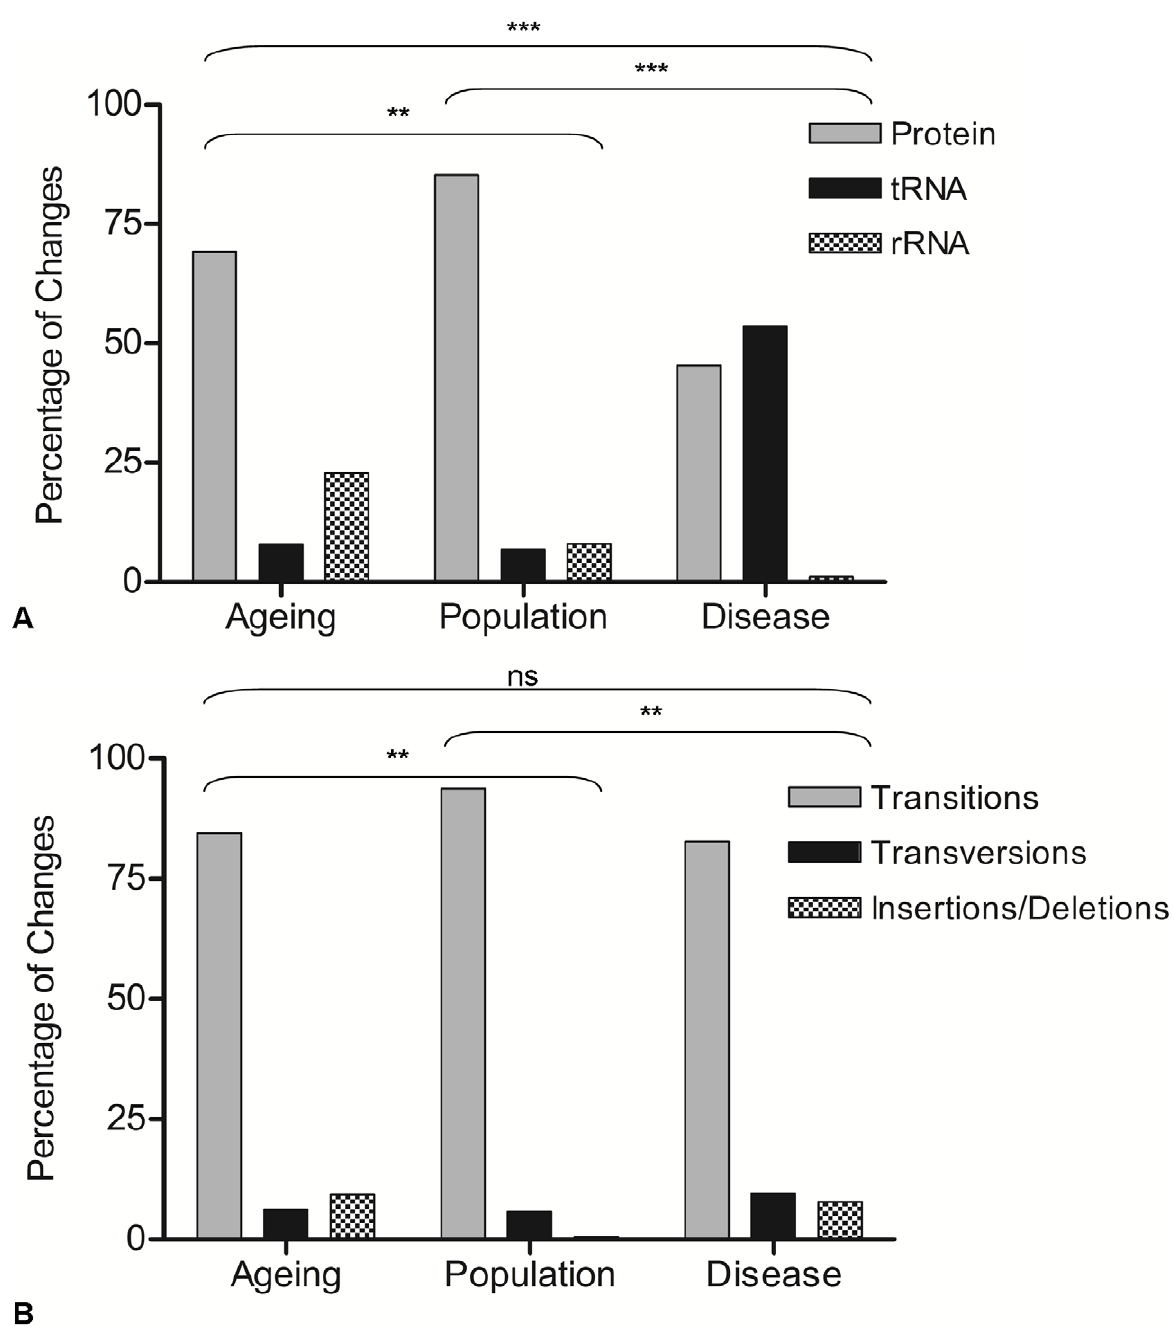
Figure 1. Gene location and types of mutations observed in ageing, population, and disease. A: Gene location of mutations. Data are represented as the percentage of the total coding region mutations. Contingency analysis with Bonferroni correction for multiple testing was carried out on the frequencies of the changes in each gene type (ageing n=117, population n=182, disease n=176). Thresholds for statistical significance are; *** , 0.0003, ** 0.003, *=0.017. B: Types of changes observed in ageing, population and disease. Data are represented as the percentage of the total coding region mutations. Contingency analysis with Bonferroni correction for multiple testing was carried out on the frequencies of the changes in each mutational category. Thresholds for statistical significance are; *** , 0.0003, ** 0.003, *=0.017.